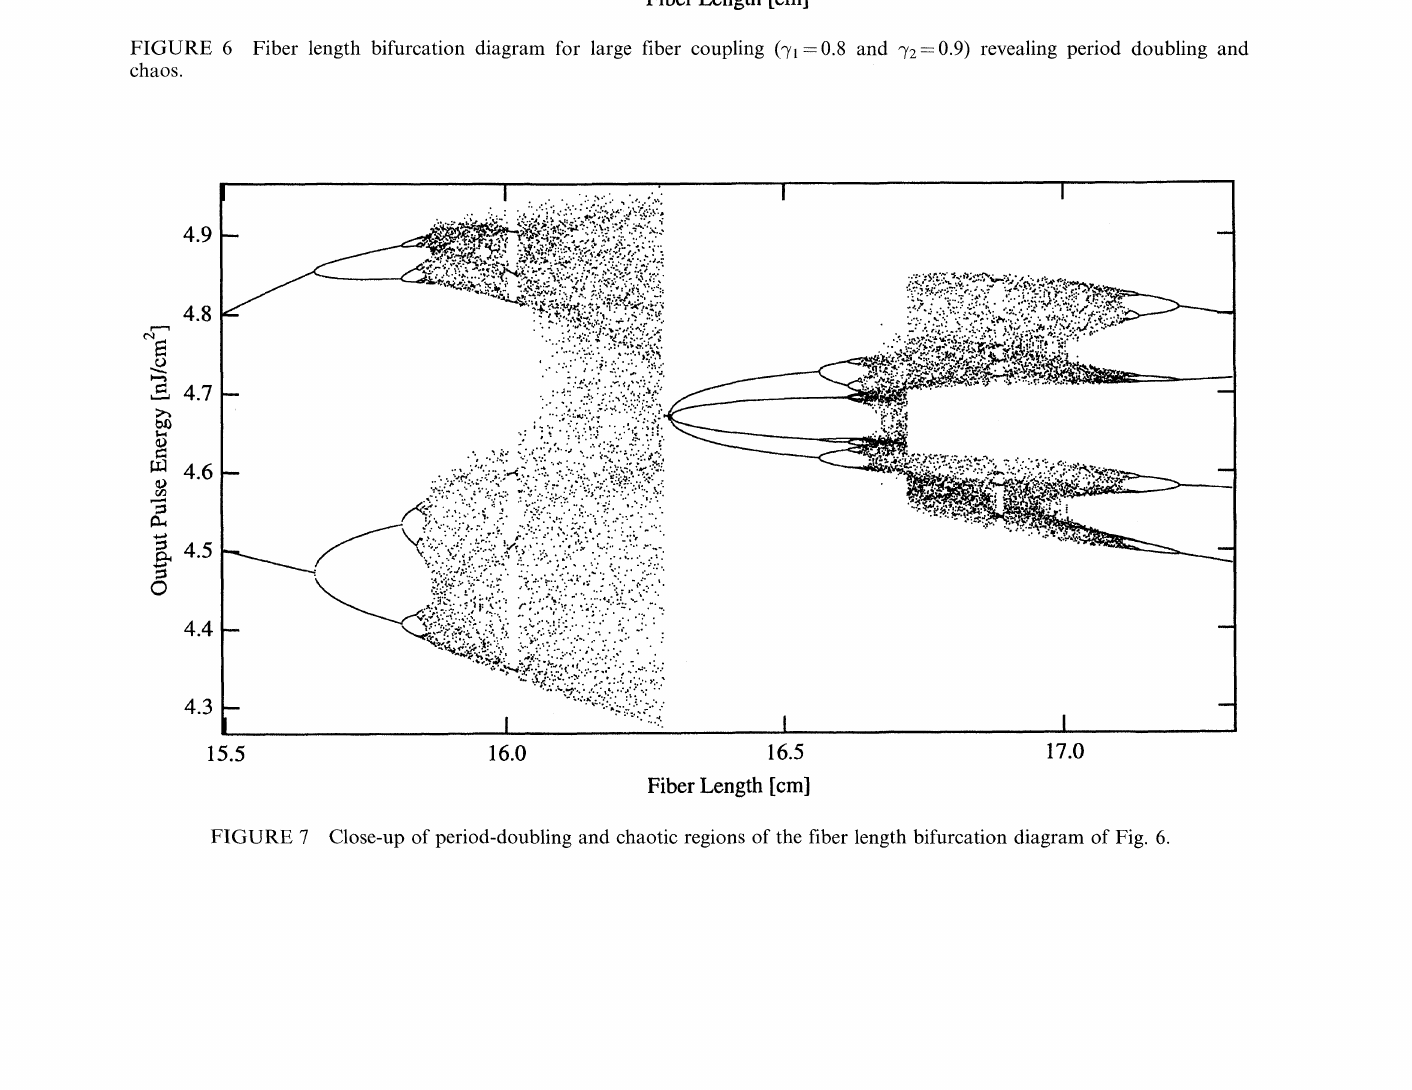
FIGURE 6 Fiber length bifurcation diagram for large fiber coupling (71 =0.8 and 72--0.9) revealing period doubling and chaos.